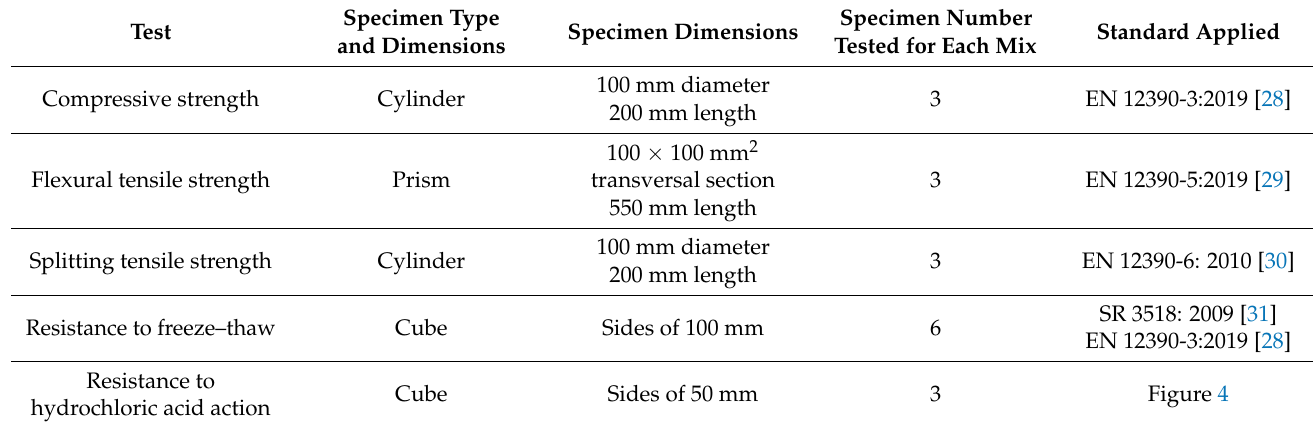
Table 1. Specifications for the mechanical and durability